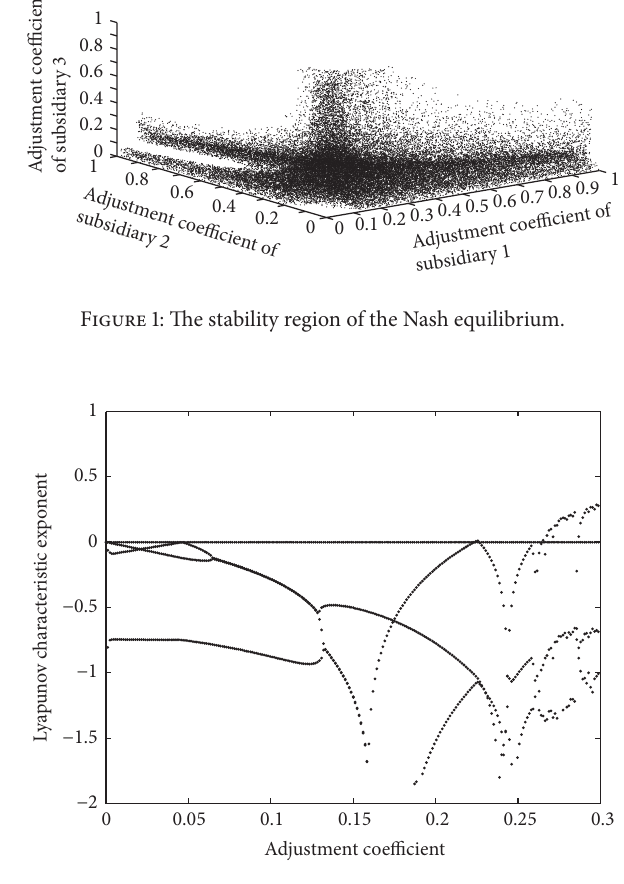
Figure 2: Lyapunov characteristic exponent of the dynamic deci- sion-making